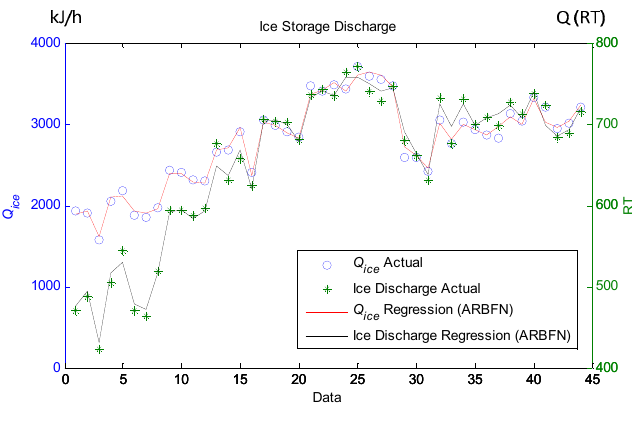
Figure 6. Discharge process net.